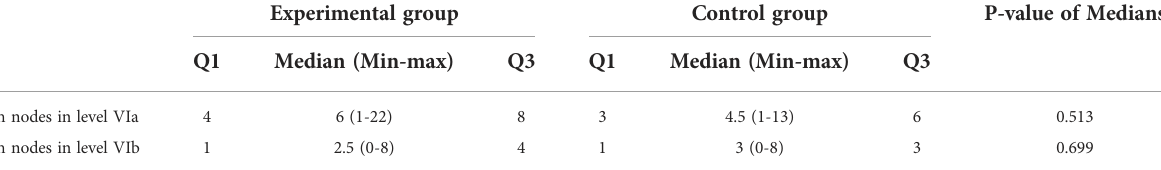
TABLE 4 Dissected lymph nodes in level VI.